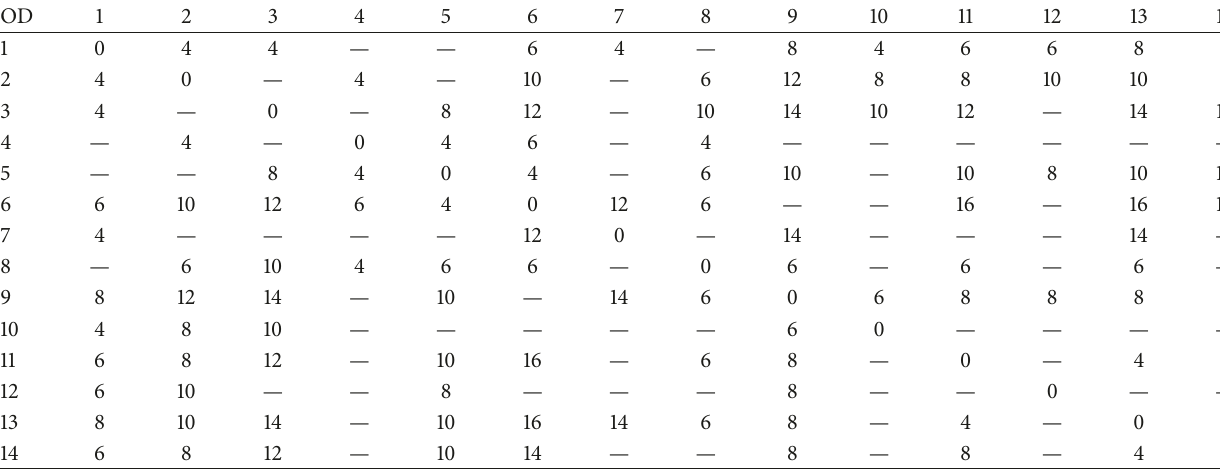
Table 4: Service level 𝑇 𝑚 for each OD pair 𝑚